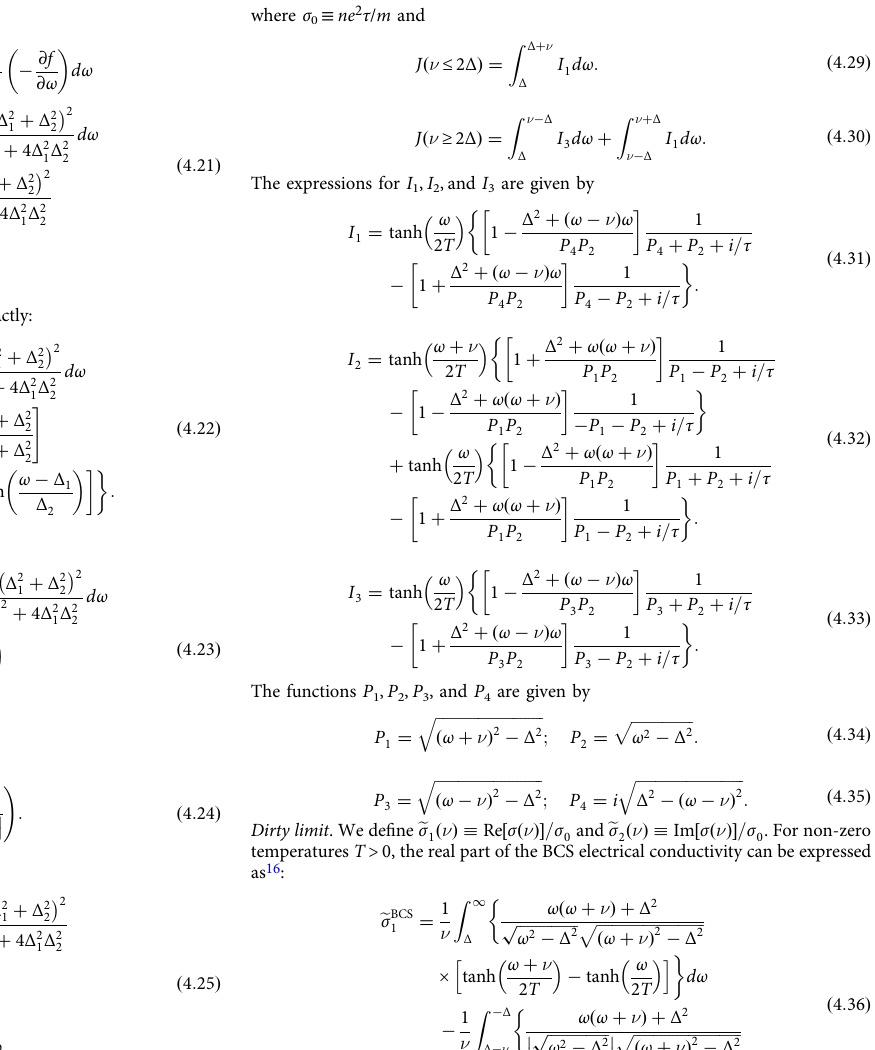
p (cid:15) ffiffiffiffiffiffiffiffiffiffiffiffiffiffiffiffi (cid:15) (cid:15) ω 2 (cid:1) Δ 2